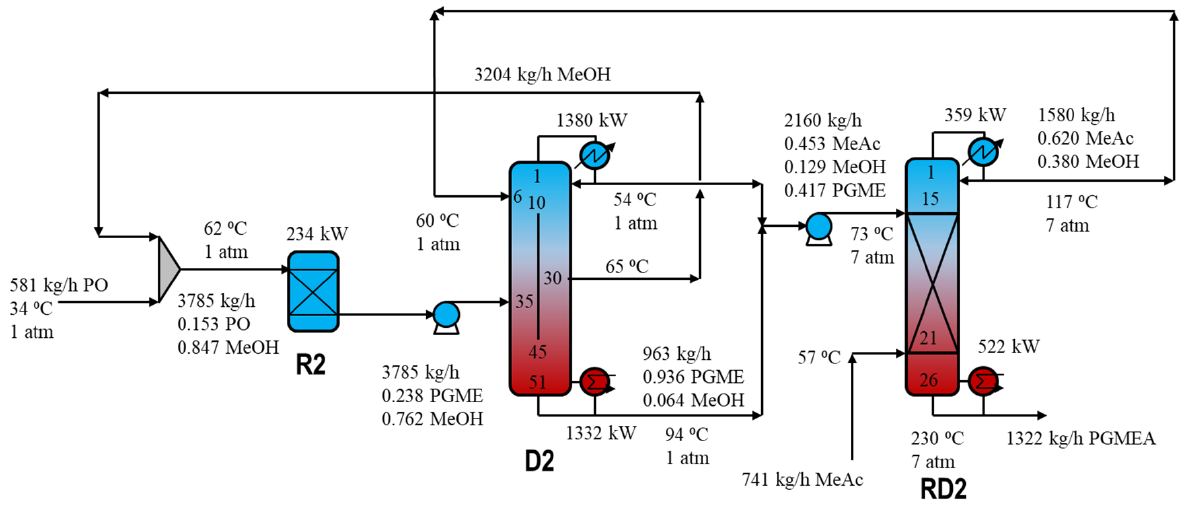
Figure 8. Pressure swing-based RD and DWC for the PGMEA production process.